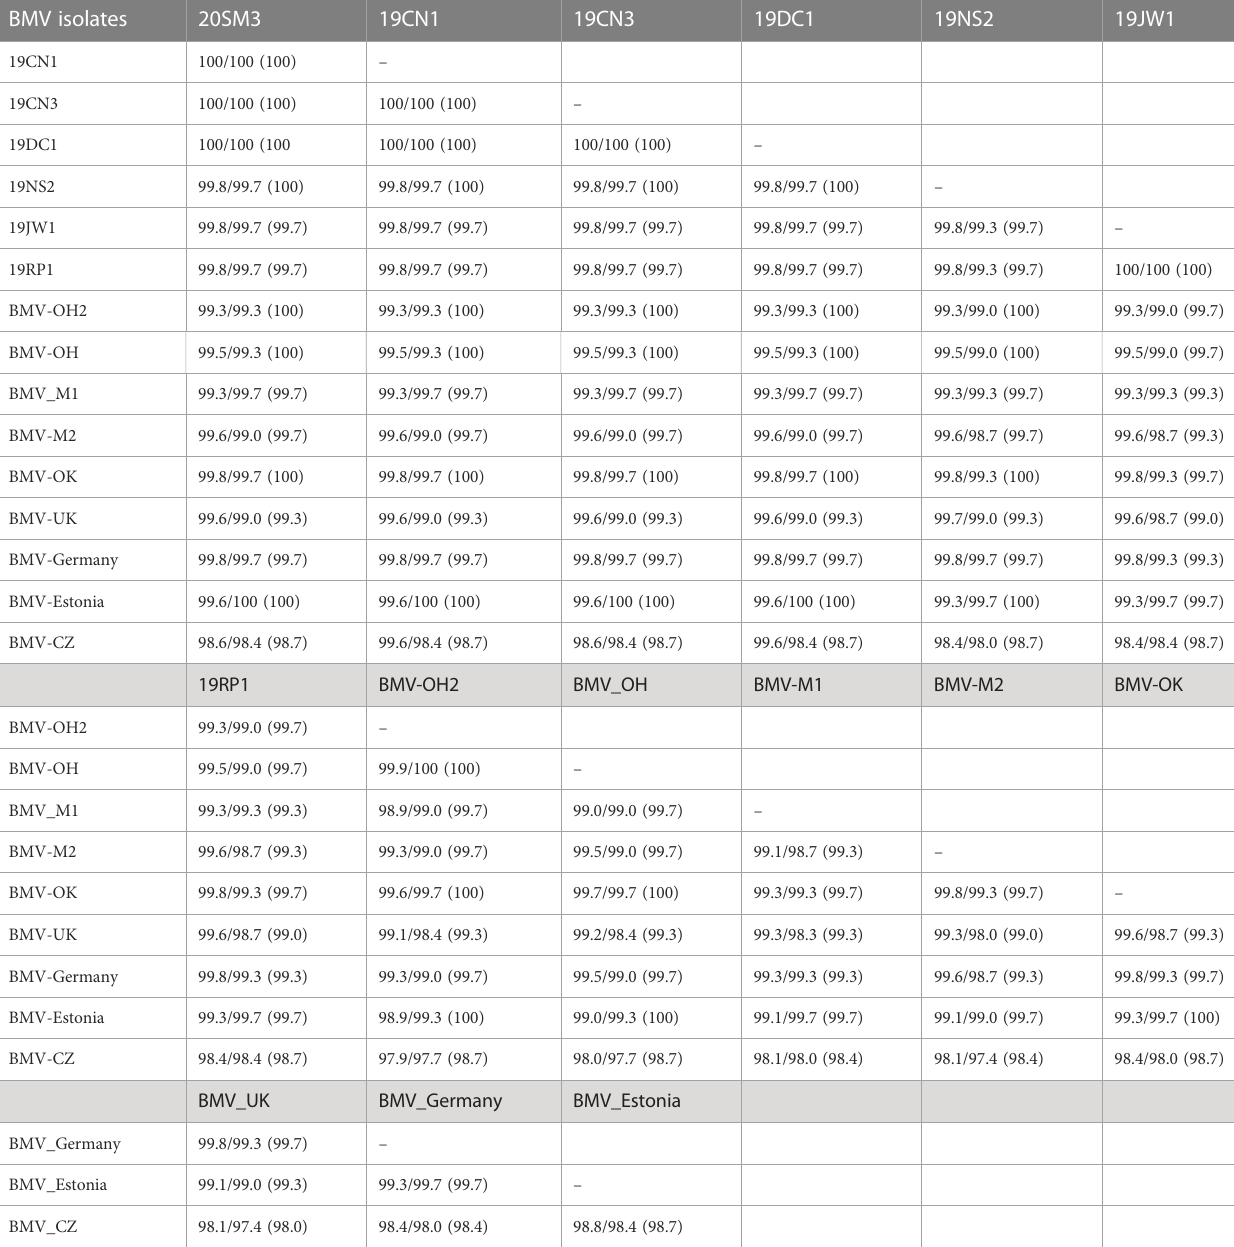
TABLE 3 Nucleotides/amino acid sequence identity (similarity) of RNA3/RNA3a (Movement protein, MP) genome of brome mosaic virus (BMV) isolates from Kansas and other known BMV isolates retrieved from GeneBank. BMV